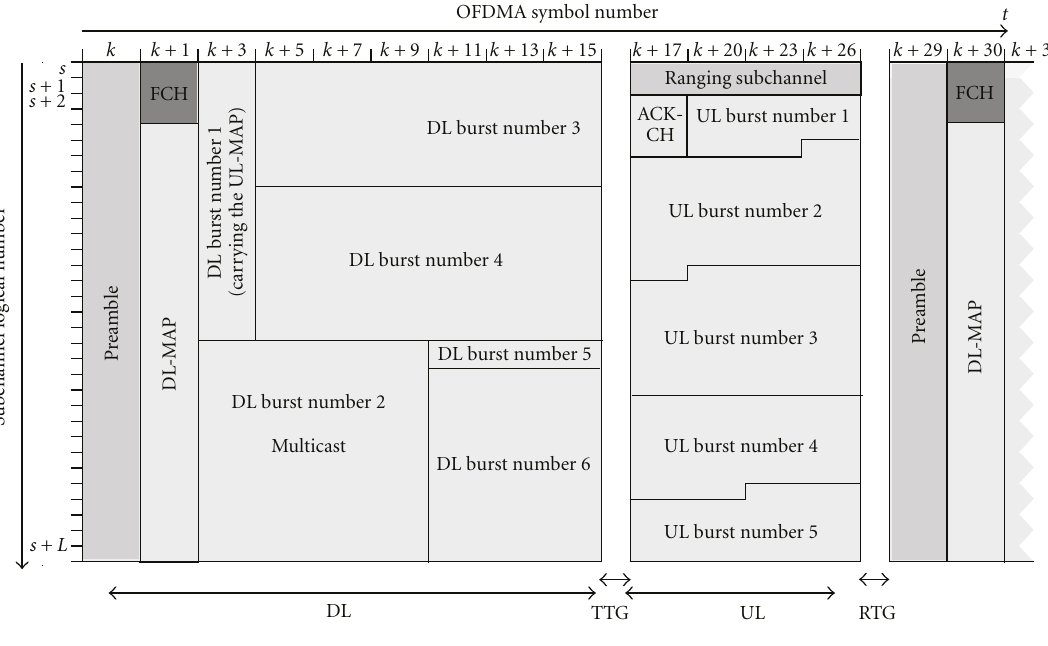
Figure 4: IEEE 802.16 frame